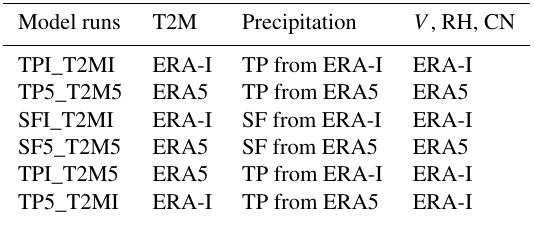
Table 3. Model runs and atmospheric forcing data in model simu- lations, where TP is total precipitation, SF is snowfall, V is wind at 10m height, RH is relative humidity and CN is total cloud cover. Model runs